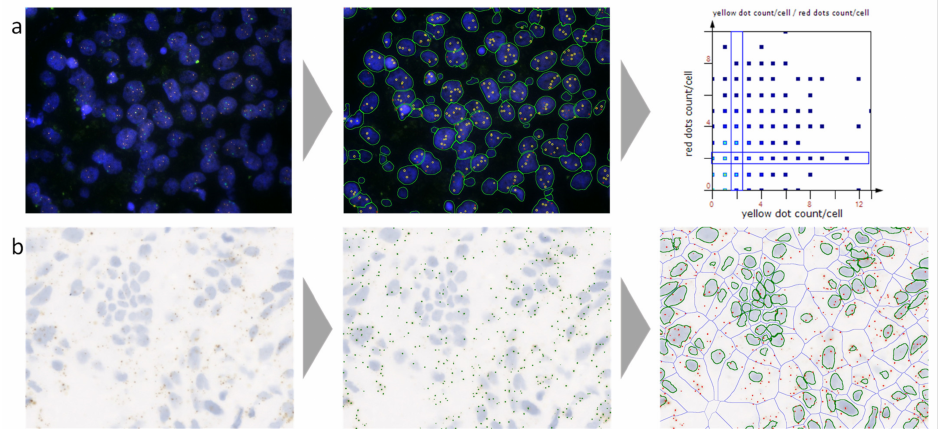
Figure 2. A representative example of automated analysis of fluorescence in situ hybridization (FISH) and RNA in situ hybridization (ISH) stained cells using a next-generation digital pathology platform. ( a ) FISH staining (blue, nuclei stained for 4 (cid:48) ,6-diamidino-2-phenylindole (DAPI); red and yellow dots, FISH probes); on the left the original image is shown, in the middle the corresponding analyzed image including cell and dot detection mask, and on the right the analyzed data visualized in a scattergram. ( b ) RNAscope staining (blue, nuclei stained for hematoxylin; brown, RNAscope staining); on the left the original image is shown, in the middle the original image overlaid with the detected dot mask, and on the right the original image overlaid with the nuclei mask, the cellular mask, and the identified dot mask. Both images were provided by and analyzed using TissueGnostics’ image cytometry solution